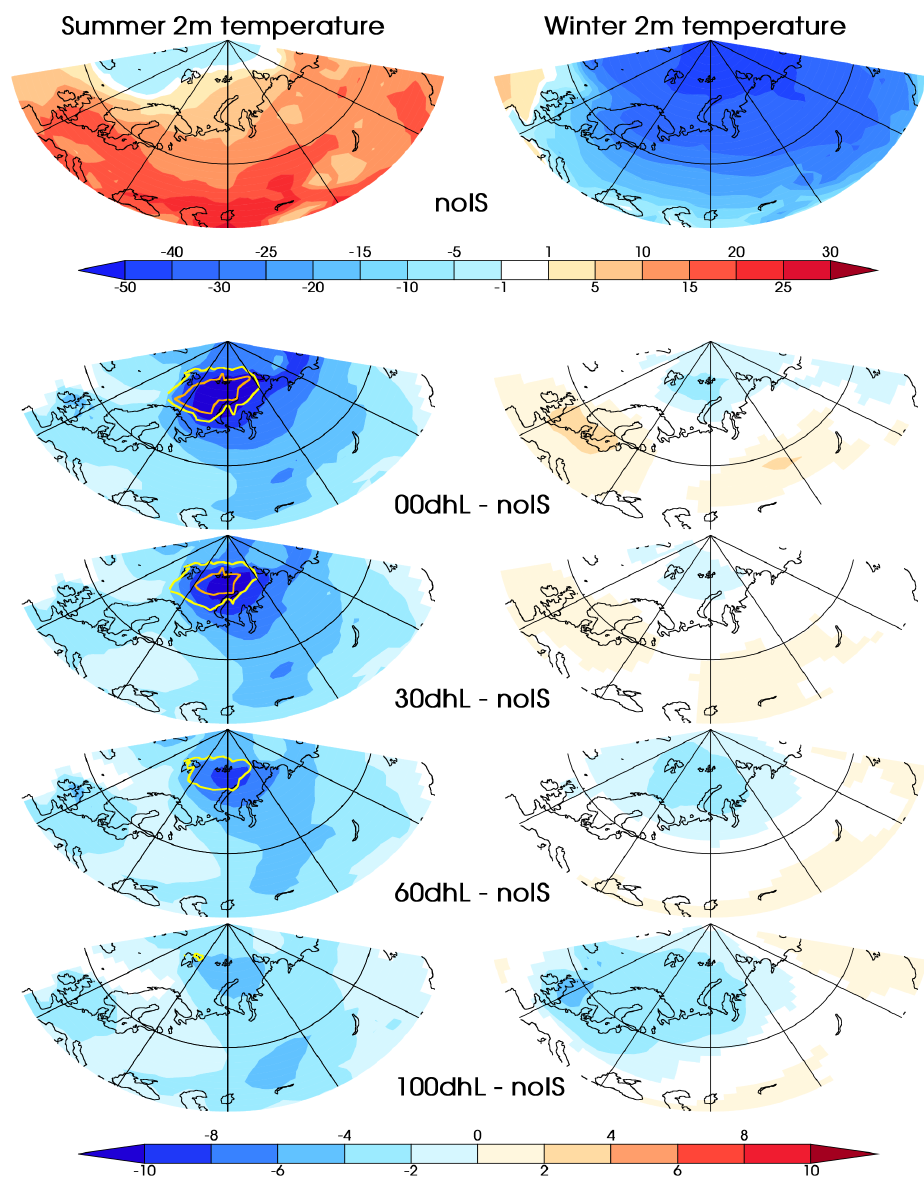
Figure 3. 2m summer (left) and winter (right) temperature without the LIS (noIS) and anomaly of the 2m temperature between the xx dhL experiments and the noIS experiment; we can therefore quantify the impact of the LIS presence, depending on its topography. The visible surface albedo difference between xx dhL and noIS experiments are represented by orange contours (albedo difference = 0.4) and yellow contours (albedo difference = 0.2). The statistical significance of the patterns of temperature anomalies has been checked using a two-sided Student t test with a p value = 0.05. The white shading indicates areas where the anomaly is not